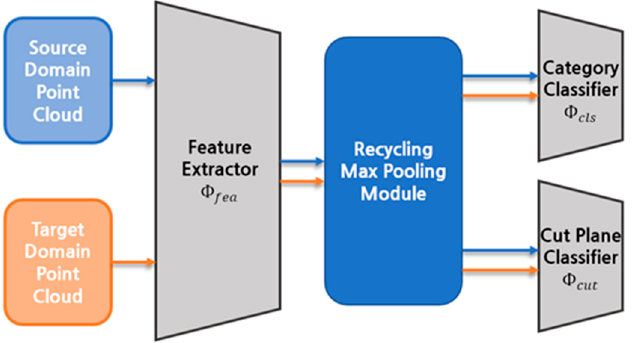
Figure 1. Concept of our domain adaptation method on point cloud classification.